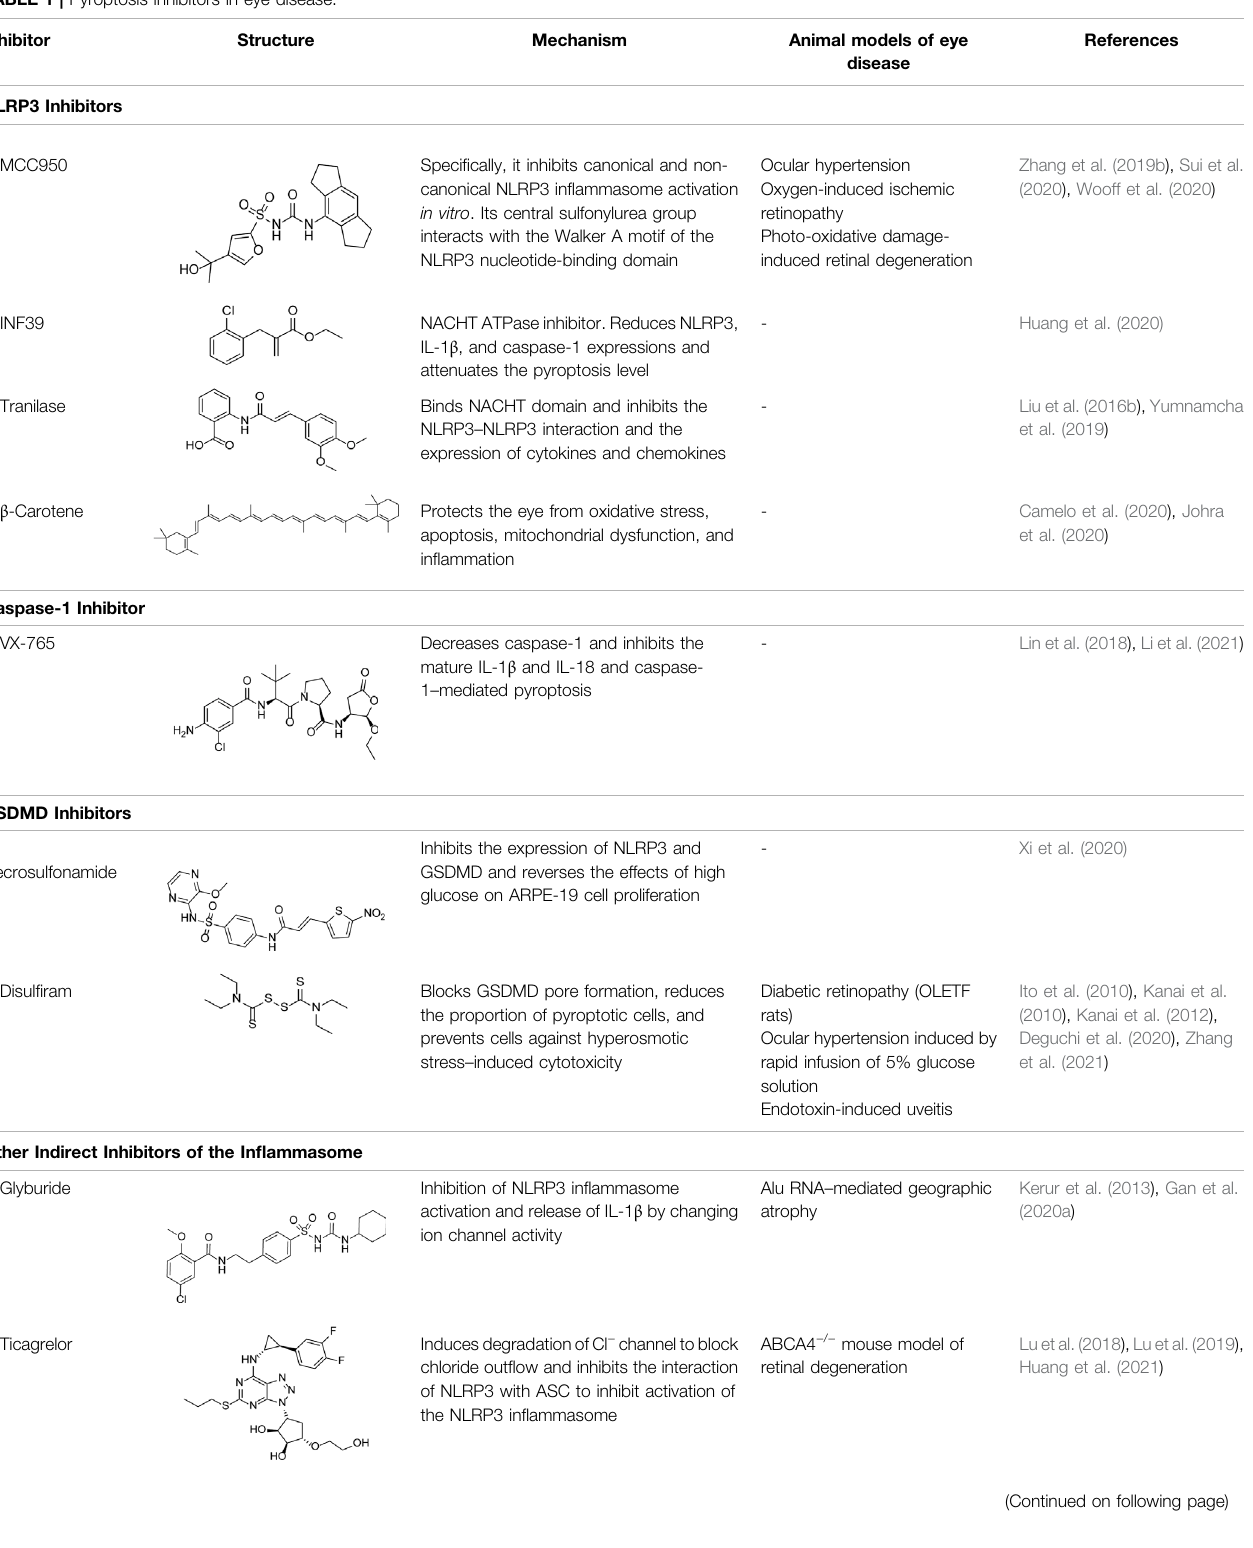
TABLE 1 | Pyroptosis inhibitors in eye